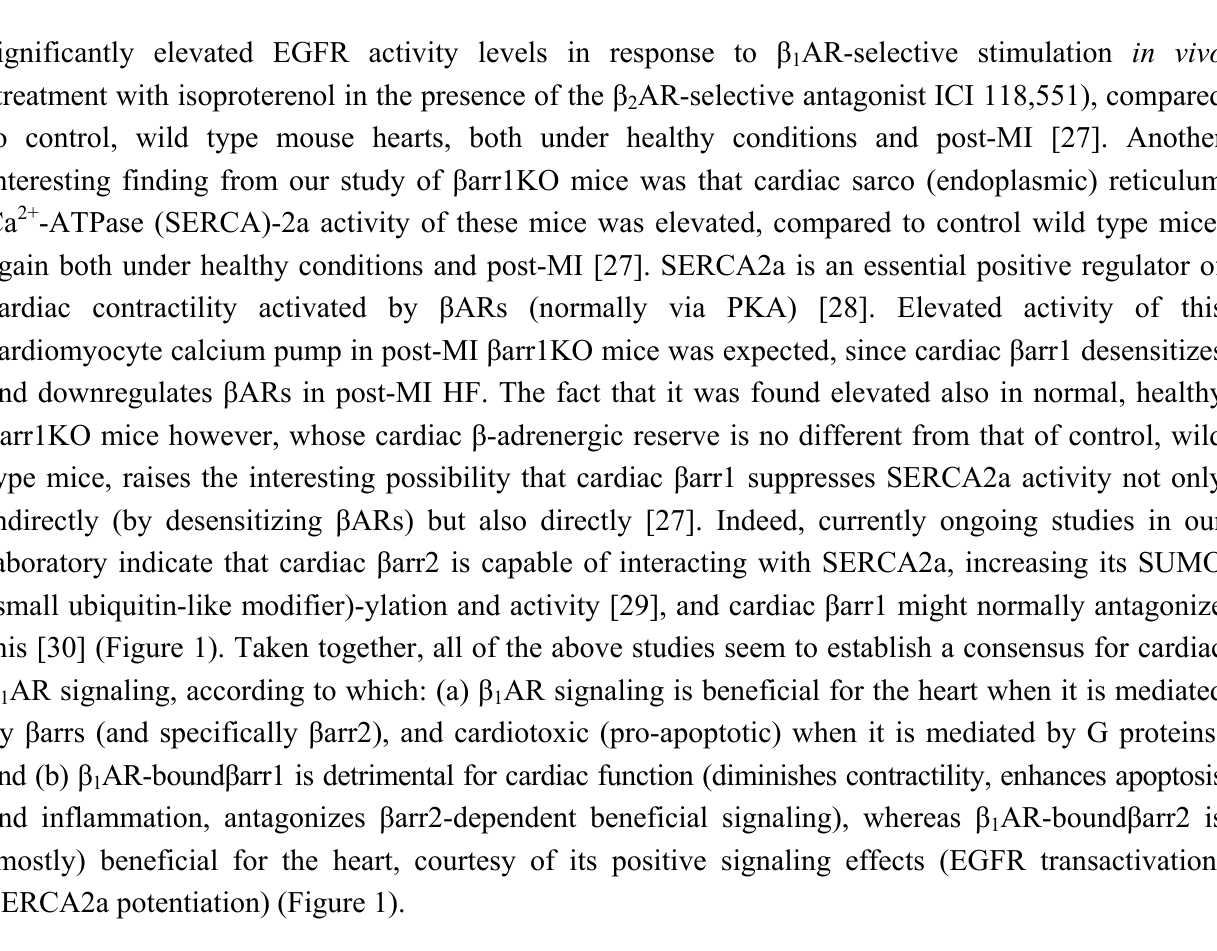
Figure 1. Schematic illustration of some important signaling pathways inside a cardiac myocyte affected by the two β arrs. SR, sarcoplasmic reticulum; PLB, phospholamban; , inositol (1,4,5)-trisphosphate; ATP, adenosine triphosphate; PLC β , phospholipase C-beta; IP 3 DAG, 2-diacylglycerol; PIP , phosphatidylinositol (4,5)-bisphosphate. See text for all other 2 acronyms and details. “?” indicates that the suggested effect is currently under investigation, “ β arr1/2?” indicates that which one of the two β arrs mediates the suggested effect (or if both β arrs do) is currently